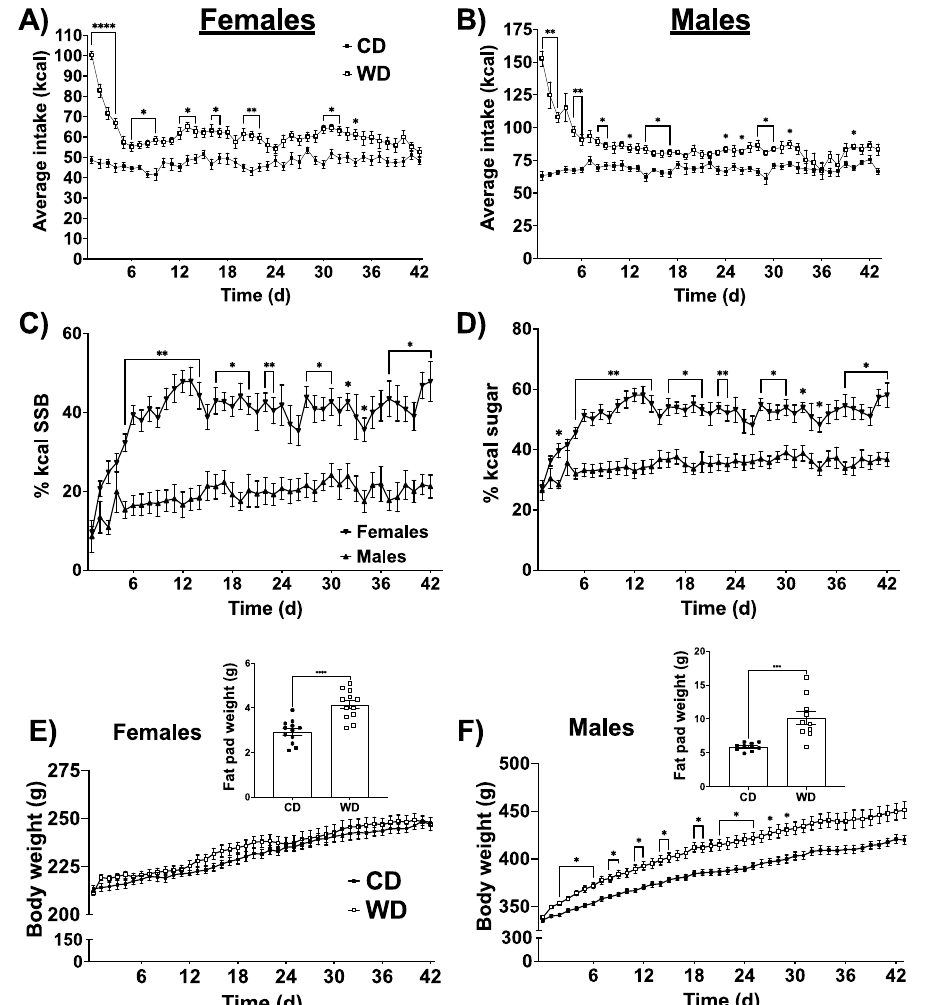
Figure 1. Average total caloric intake for females (time x diet (F(41, 902) = 5.95), p < 0.0001) ( A ) and males (time × diet (F(42, 756) = 9.37), p < 0.0001) ( B ) consuming either a Western diet (WD) containing 60% fat pellets and an 11% high fructose corn syrup (HFCS) beverage or a chow diet (CD). Percentage of calories consumed from the 11% HFCS (time × sex (F(41, 820) = 2.63), p < 0.0001) ( C ). Percentage of total sugar in the diet (from both pellets and 11% HFCS combined) are shown in ( D ; (time x sex (F(41, 820) = 2.63), p < 0.0001). Body weight from the day before starting the respective diet to the day of sacrifice is shown for females ( E ) and males ( F ; (F(43, 774) = 4.753, p < 0.0001)). Unilateral combined body fat from perirenal, perigonadal, and subcutaneous fat pads at the time of sacrifice is shown for females and males ( E , F inset, respectively). Data are analyzed by two-way repeated-measures ANOVA with Sidak’s post hoc analyses for all figures except for body fat, which are analyzed using Student’s two tailed t tests. Data are shown as the means ± SEMs. * p < 0.05, ** p < 0.01. *** p < 0.005, **** p < 0.0001.